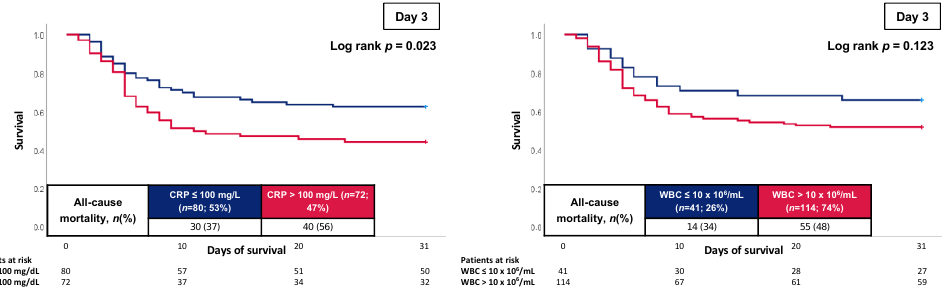
Figure 3. Kaplan–Meier curves of CRP and WBC count on day 3 for all-cause mortality at 30 days. Figure 3. Kaplan – Meier curves of CRP and WBC count on day 3 for all-cause mortality at 30 days.